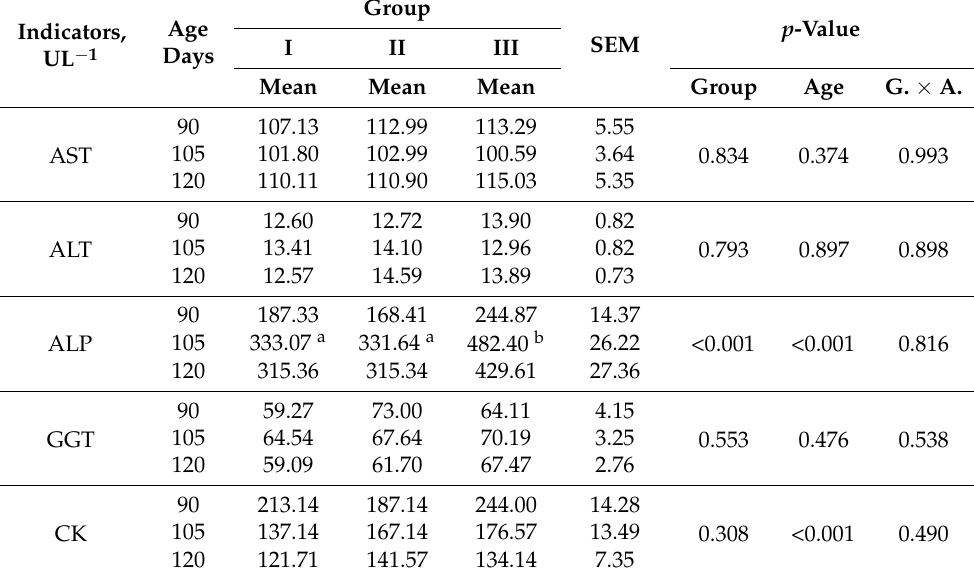
Table 6. Blood enzyme indicators in